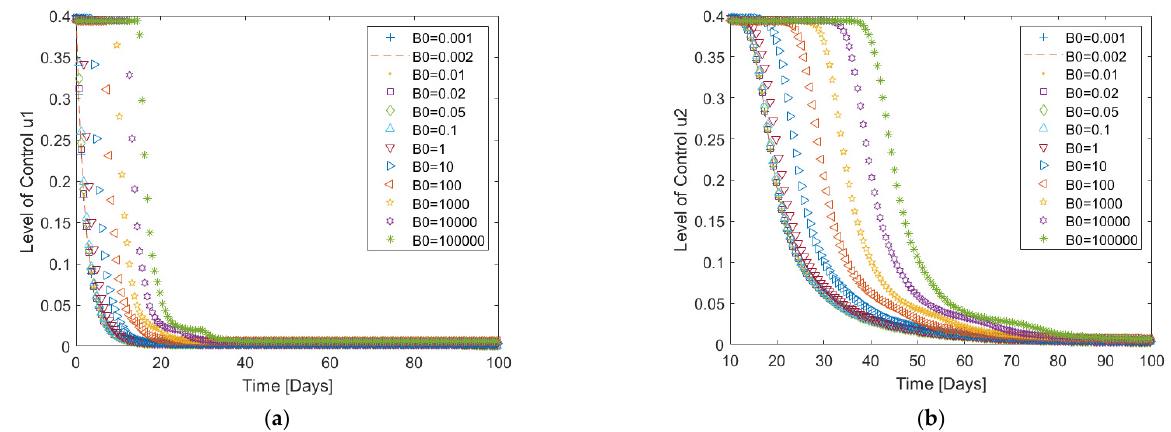
Figure 4. The control efforts u of Policy 1 against the changes in B 0 weightings of Equation (15).